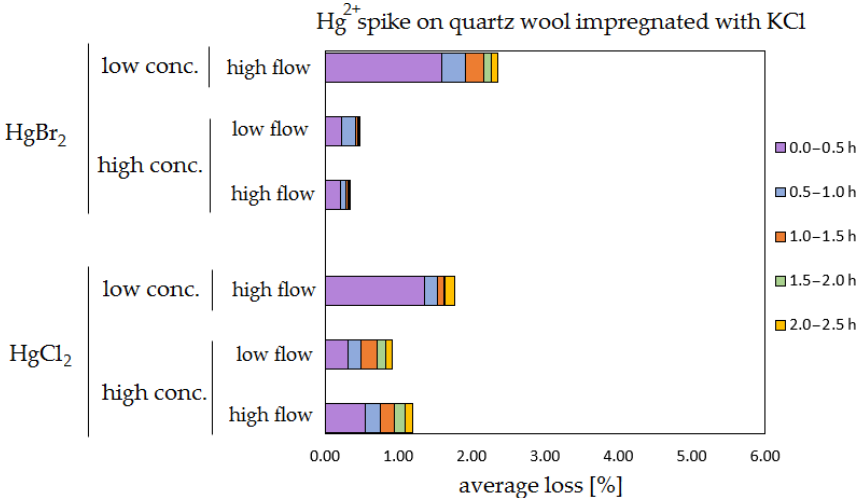
Figure 8. Results of the stability test for the 197 Hg 2 + (radiotracer) spike on quartz wool impregnated with KCl. Low concentrations were loaded with less than 1ng Hg per time period, and high concentrations were loaded with more than 50ng of Hg per time period. Low airflow experiments were performed with 100mLmin − 1 airflow, while high airflow experiments were performed with 400mLmin − 1 flow.